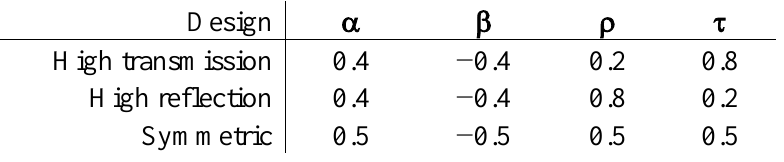
Table 1. Coupler coefficients used for the three proposed manufacturing cases.